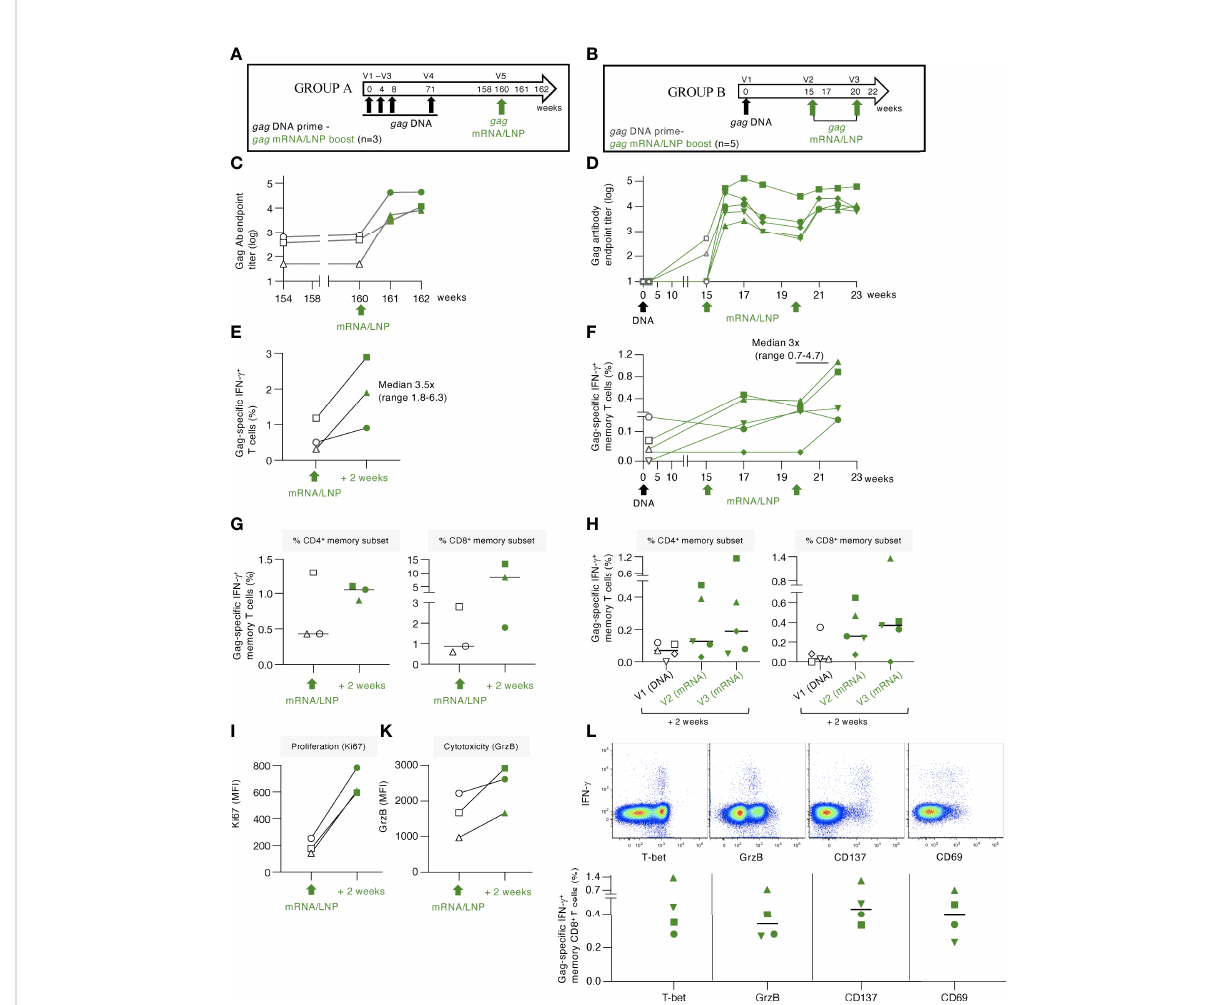
FIGURE 6 gag mRNA/LNP booster vaccination of macaques with pre-existing Gag T cell immunity increased T cell responses. (A, B) Schematic representations of the DNA prime - mRNA/LNP booster vaccination regimens. (A) The macaques (n=3) in group A previously received 4 HIV gag DNA vaccinations (week 0, 4, 8 and 71). After a rest period of 89 weeks, they received a single gag mRNA/LNP (25 m g) booster vaccination (V5). (B) Animals in group B received a single gag DNA prime (V1; 2 mg dose), followed 15 weeks later by two gag mRNA/LNP booster vaccinations (V2, V3; 25 m g dose) spaced 5 weeks apart. (C, D) Gag-speci fi c Ab endpoint titers (log) were measured by ELISA during the course of the studies. (C) Gag Ab were measured starting 6 weeks before study start (week 154), at the day of vaccination (week 160), and 2 and 4 weeks upon the mRNA/LNP boost. (D) Gag Ab responses were measured after the gag DNA vaccination, at the start and post the mRNA/LNP vaccinations. (E, F) Gag-speci fi c T cell responses measured by fl ow cytometry at the indicated timepoints for (E) group A and (F) group (B) Grey symbols denote responses after the DNA vaccination, green symbols denote responses after mRNA/LNP vaccination. (G, H) Gag-speci fi c responses in total (CD3 + IFN- g + ) and memory (CD3 + CD95 + IFN- g + ) T cell subsets are shown. Changes in (I) proliferation, measured by Ki67 staining, and (K) cytotoxicity, measured by granzyme B content, are shown for animals from group A. (L ) Dot plots (upper panels) from a representative animal (LI19) from group B showing T-bet, granzyme B content and expression of the co-stimulatory immune checkpoint molecule CD137 and the CD69 activation marker among the Gag-speci fi c IFN- g + memory CD8 + T cells after the last vaccination. The graph (lower panel) shows the peak responses after the last vaccination with data from 4 of 5 animals with positive Gag-speci fi c memory (CD8 + CD95 + IFN- g + ) T cell